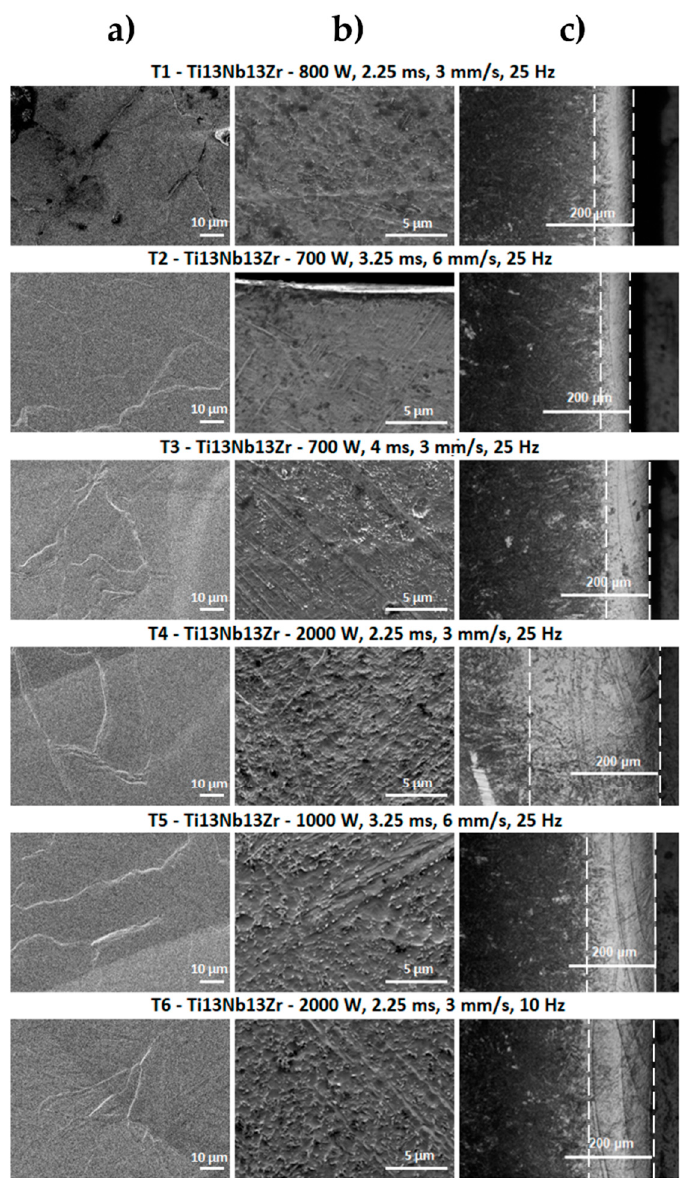
Figure 4. SEM images of Ti13Nb13Zr alloy after laser processing. ( a ) Surface topography; ( b ) cross-sections; ( c ) images from an optical microscope.